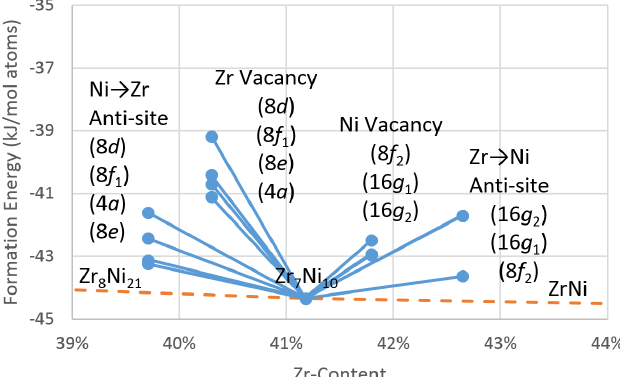
Figure 2. Density functional theory (DFT) formation energies for Zr 7 Ni 10 and its point defects with tie lines.